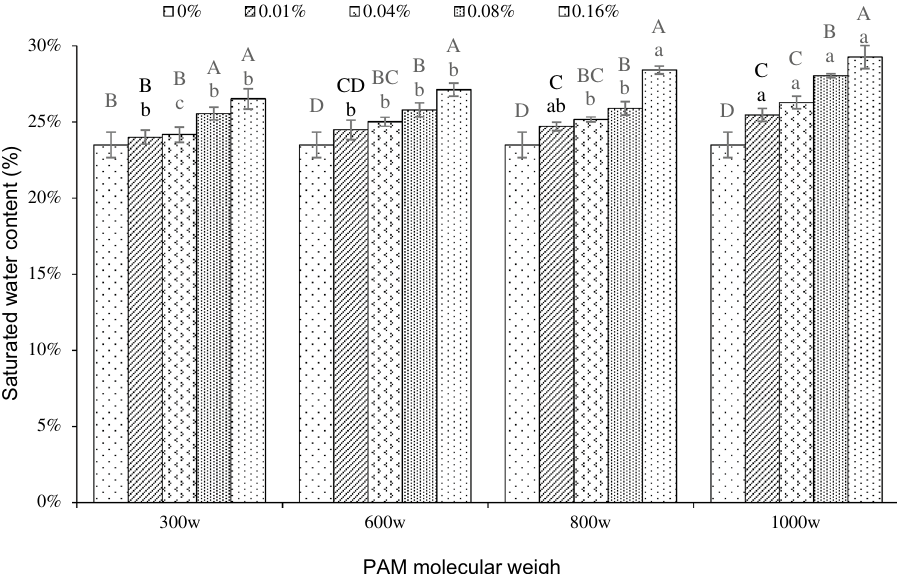
Figure 1. Saturated water content of iron tailings for four molecular weight (300w, 600w, 800w and 1000w) and five mass concentration (0%, 0.01%, 0.04%, 0.08% and 0.16%) of PAM. Different capital letters indicate significant differences in saturated water content under different mass concentrations of PAM with the same molecular weight, and different lowercase letters indicate a significant difference in saturated water content under different